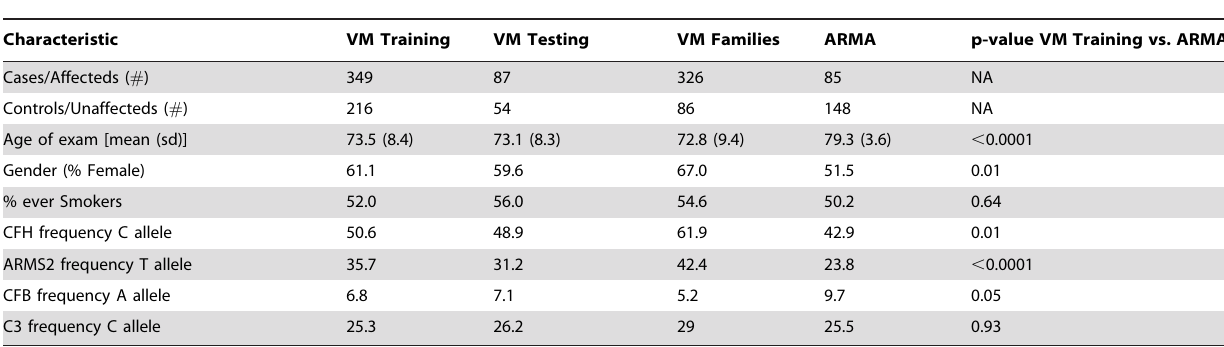
Table 2. Characteristics of the